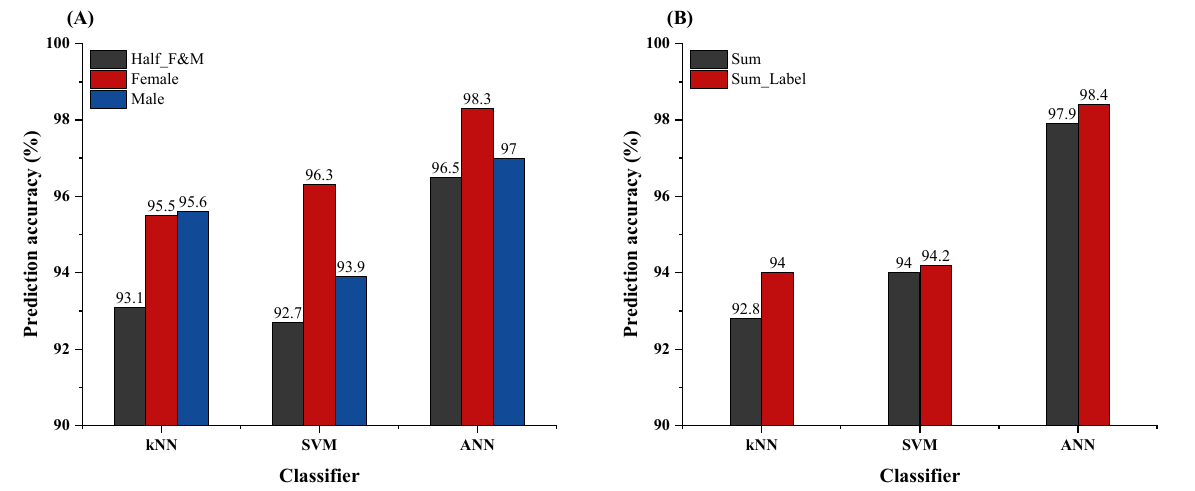
Figure 5. Total prediction accuracy statistics of three classifiers (kNN, SVM and ANN) applied to a test set for hand gesture recognition for two methods considering sex differences: ( A ) differentiating- the-sex dataset and ( B ) adding a sex labeling.